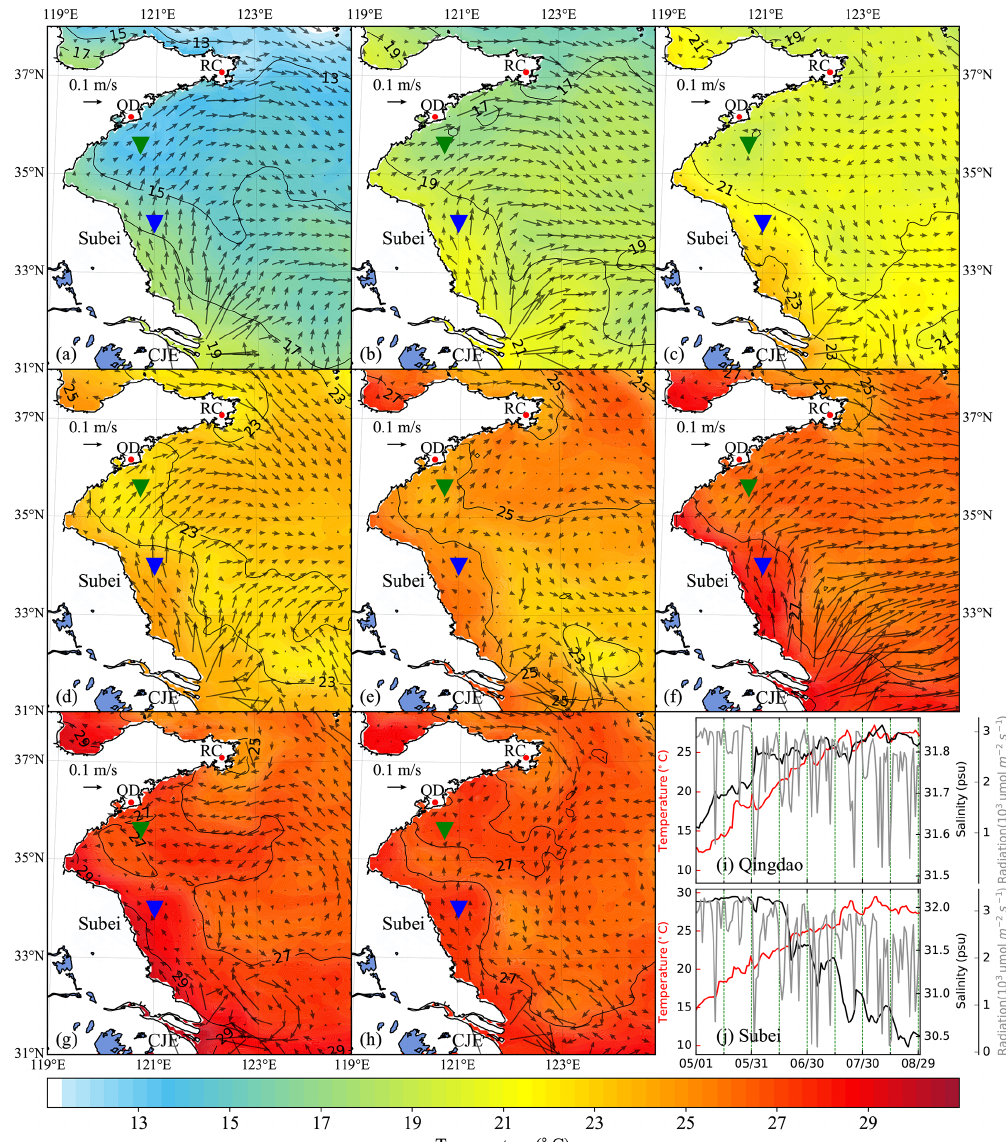
Figure 5. Time-averaged distribution of surface current and temperature of every 15d duration in 2014: (a) 1–15 May, (b) 16–30 May, (c) 31 May–14 June, (d) 15–29 June, (e) 30 June–14 July, (f) 15–29 July, (g) 30 July–13 August, (h) 14–29 August. The green and blue inverted triangles indicate the position of selected Qingdao (QD) coast and Subei offshore sites, respectively. Time series of surface temper- ature, salinity, and irradiation in Qingdao (i) and Subei (j)